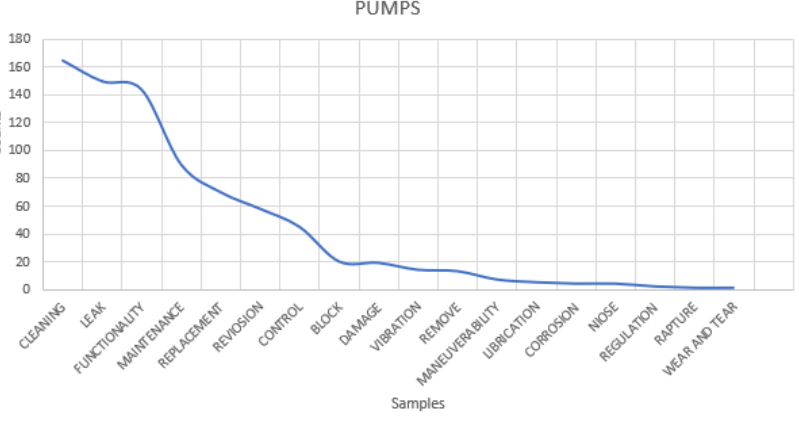
Figure 7. Frequency distribution of the fault category with respect to the notices related to